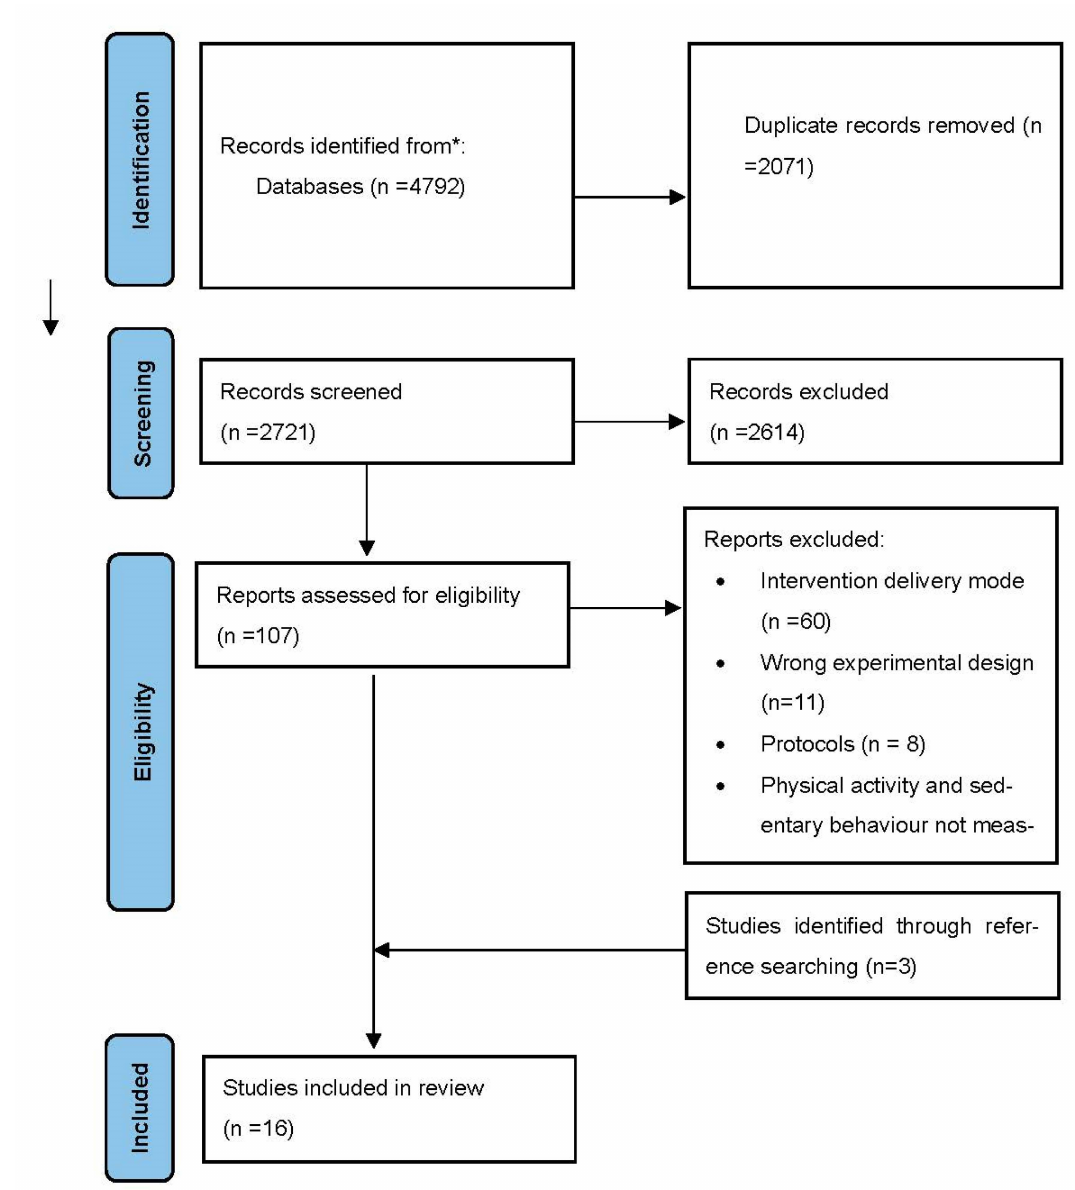
Figure 1. PRISMA diagram of the systematic literature